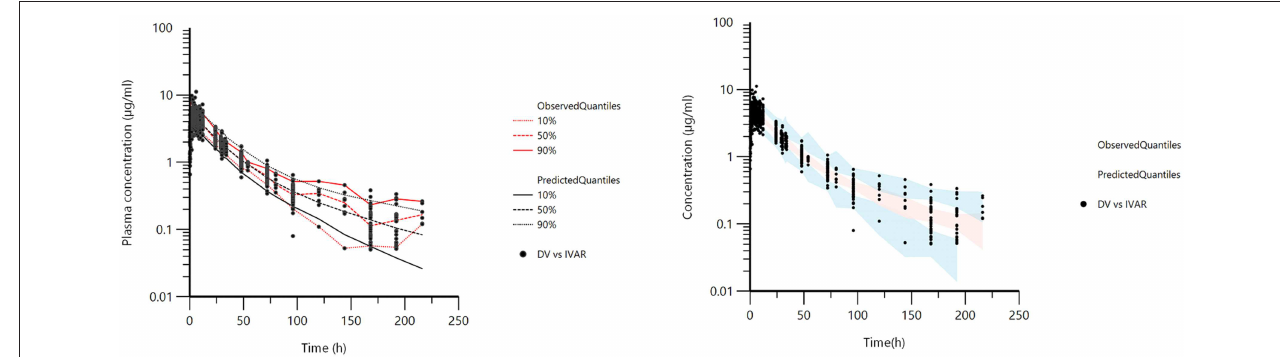
FIGURE 5 | Visual Predictive Check (VPC) obtained with 100 replicates of each animal. The observed quantiles (10, 50, and 90%) were well superimposed on the corresponding predictive check quantiles over the observed data. Theoretically, ∼ 20% of the data should be outside the plotted quantiles. The red lines are 10, 50, and 90% quantiles from the actual observed values. The black lines are the 10, 50, and 90% quantiles from the simulated observations (left) . Blue and red shaded (right) areas correspond to the 95% confidence interval of the three predicted quantiles.